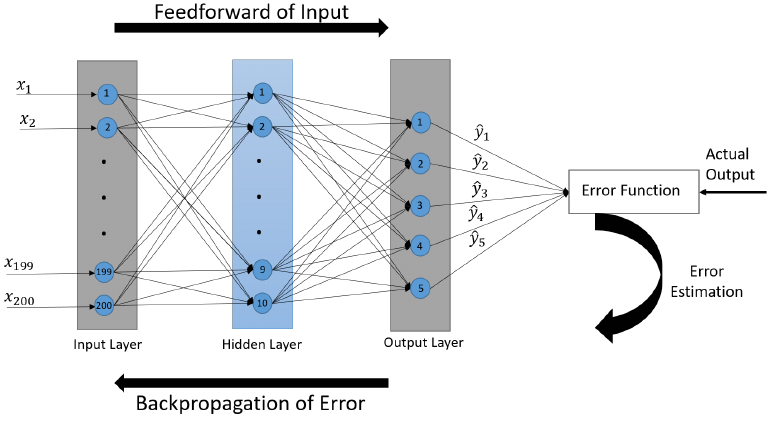
Figure 8. Structure of the designed classifier with a backpropagation